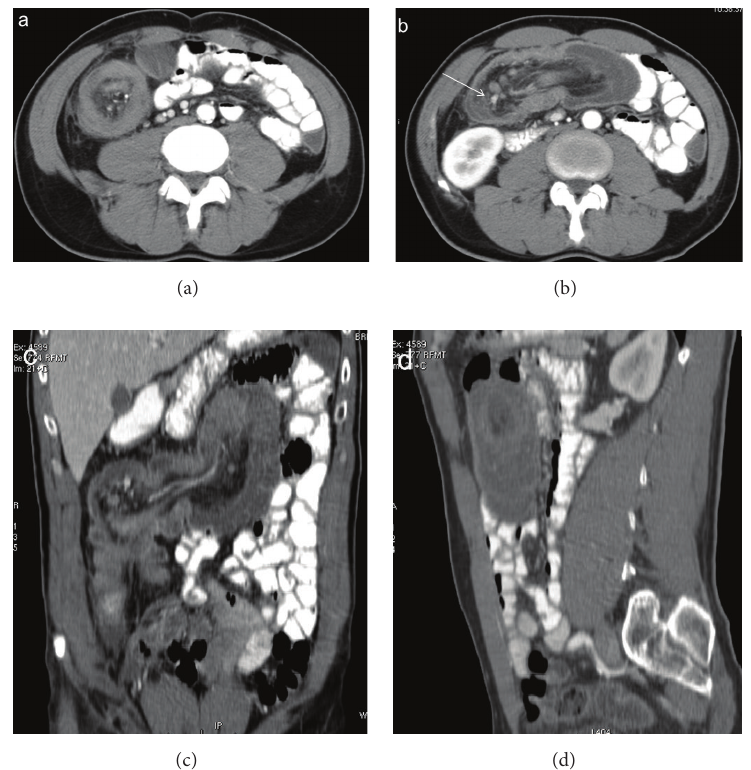
Figure2:Enterocolonic(ileocaecocolonic)intussusception.Intussusceptionmaypresentasatarget(a),reniformbilobed(b,c),andasausage- shaped (d) mass depending on the different axial CT scans or reformatted planes. Mesenteric vessels appear as enhanced linear structures between hypodense mesenteric fats (arrow). Dilated proximal bowel loops are opacified with oral contrast.